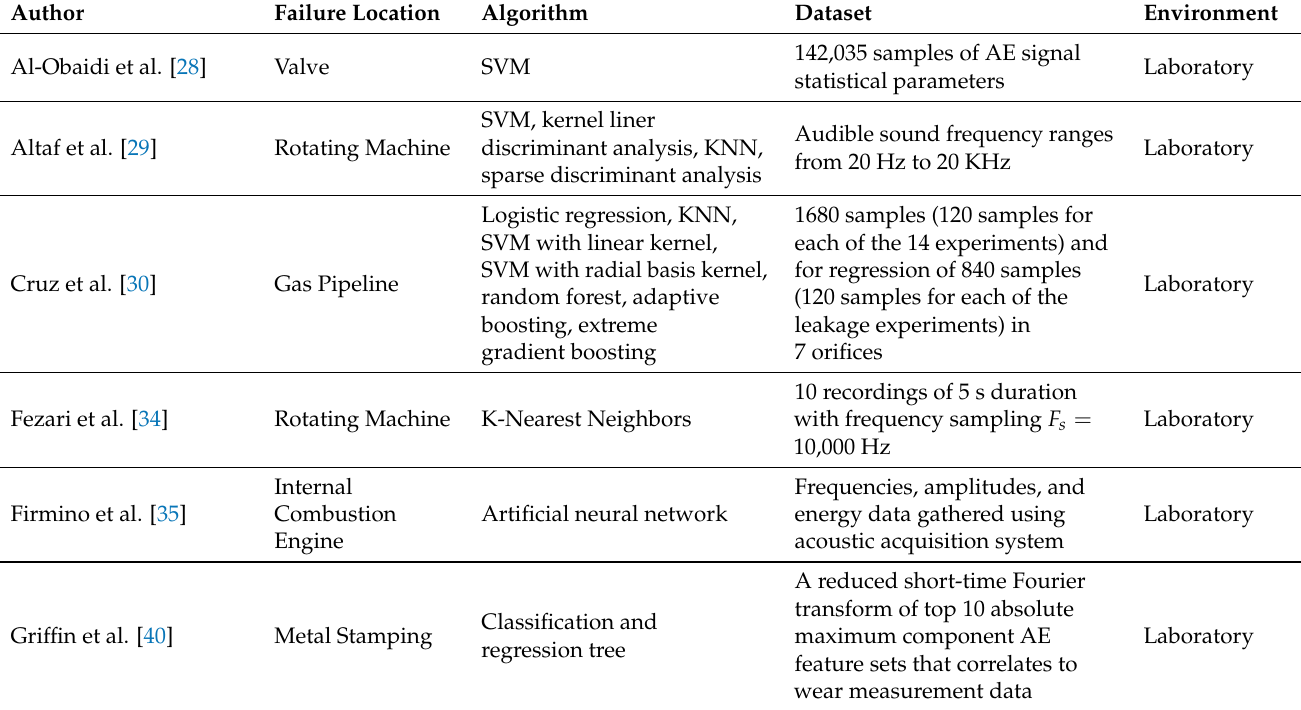
Table 10. Summary of the technical implementation of artificial intelligence aspect in mechanical failure